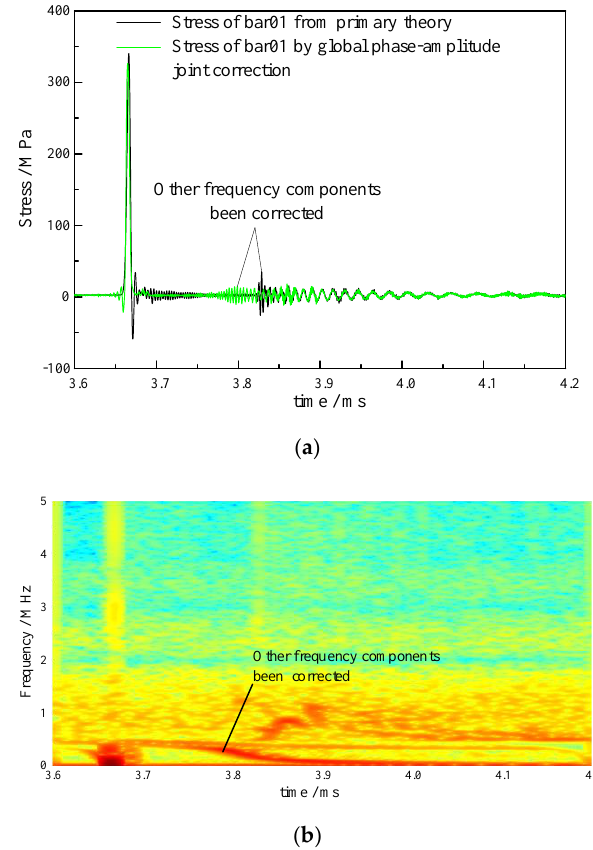
Figure 14. The result of the first order mode global phase-amplitude joint correction of bar 0 1′ s free surface velocity ( a ) Comparison of corrected stress curve with elementary theory stress curve; ( b ) Time-frequency joint spectrum of corrected stress curve.